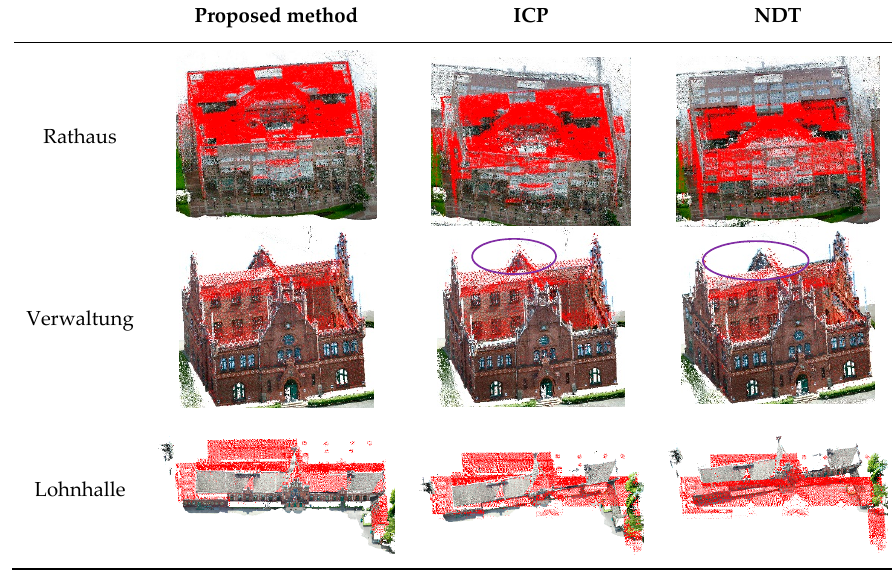
Figure 8. Poisson surface reconstruction results from: ( A ) open LiDAR data. ( B ) a façade point cloud generated from ground images. ( C ) the fusion point cloud of open LiDAR data and the façade point cloud. 3.2. Quantitative Analysis As described in Section 2.2, an iteration process is performed in the EM process to find the optimal alignment result. After less than 30 iterations, the ratio of 𝑄 to the initial 𝑄 (cid:2868) quickly declined to 1%, as shown in Figure 9A. Accurate geographical coordinates (cid:4668)𝐺 (cid:3036) (cid:4669) of target centers distributed on the façade, as provided in the dataset of “ISPRS benchmark on multi-platform photogrammetry”, are used for quantitative evaluations of the alignment results, as shown in Figure 9B.